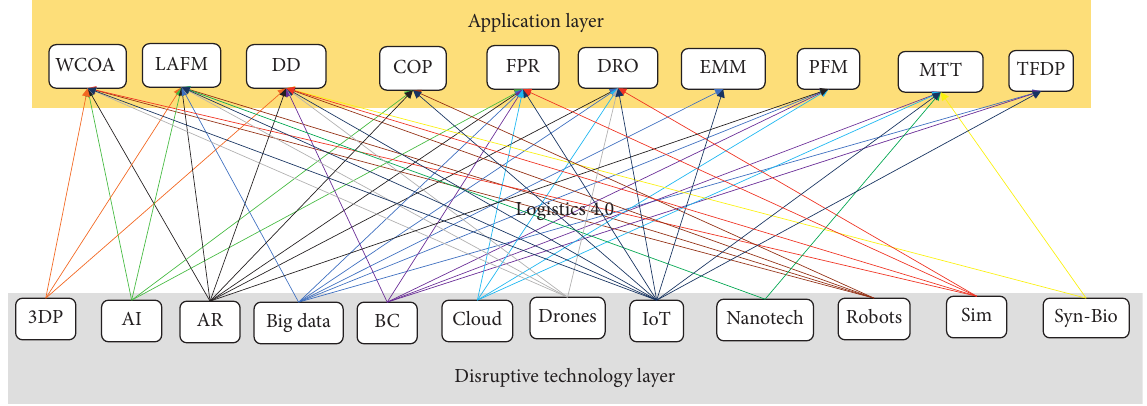
Figure 11: The convergence of disruptive technologies in logistics.